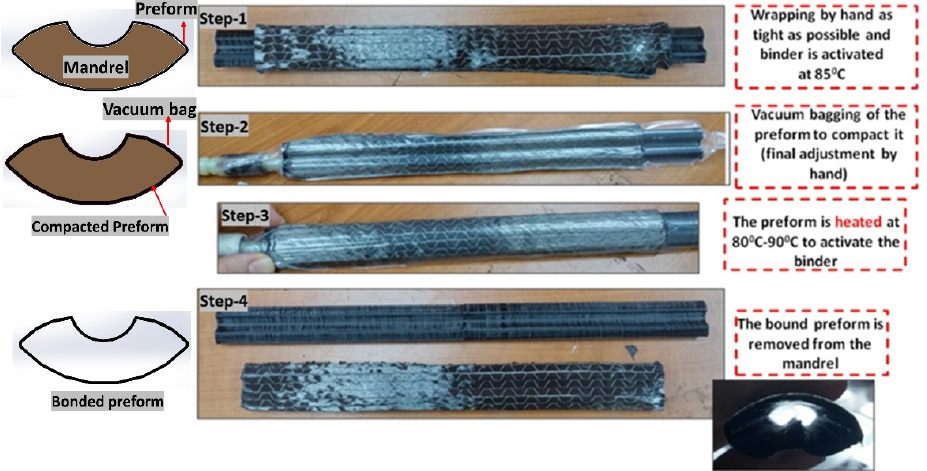
Figure 7. Fabrication steps to manufacture a tubular section.